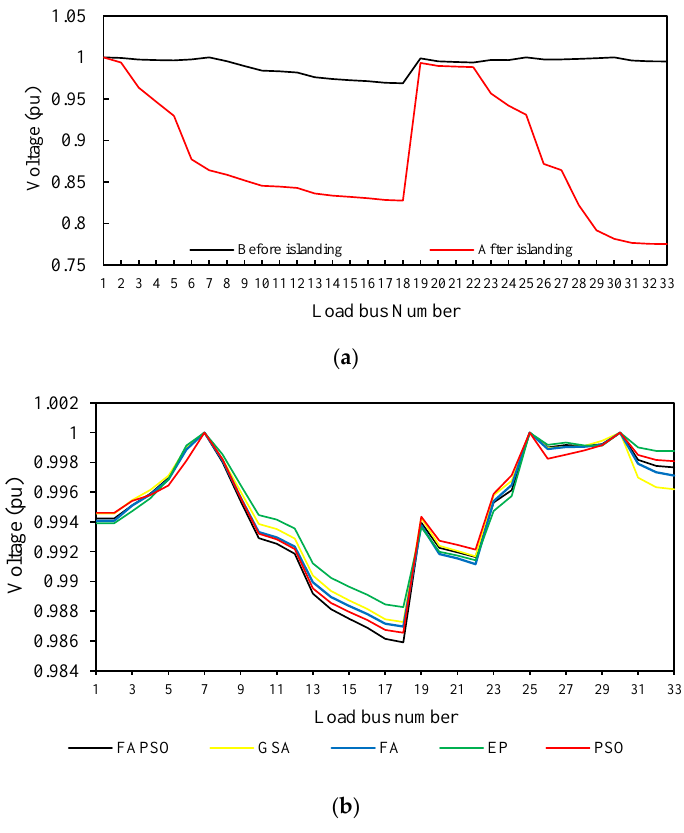
Figure 11. Voltage profile for the simulation: ( a ) Voltage profile before and after islanding at time 15:00 without load shedding; ( b ) Voltage profile after applying techniques FAPSO, FA, PSO, EP and GSA optimizations at time 15:00.